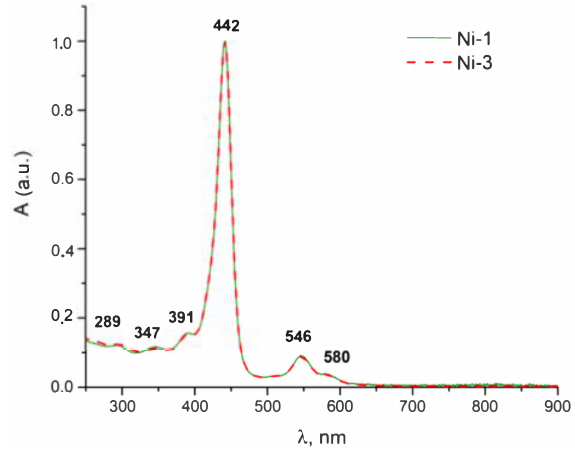
Figure 1. UV–Vis spectra of solution of Ni-1 and Ni-3 in CHCl 3 .